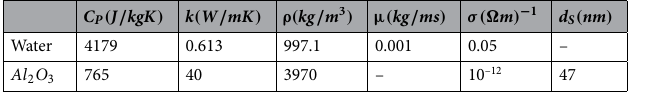
Table 1. Thermophysical properties of Al 2 O 3 -water 45